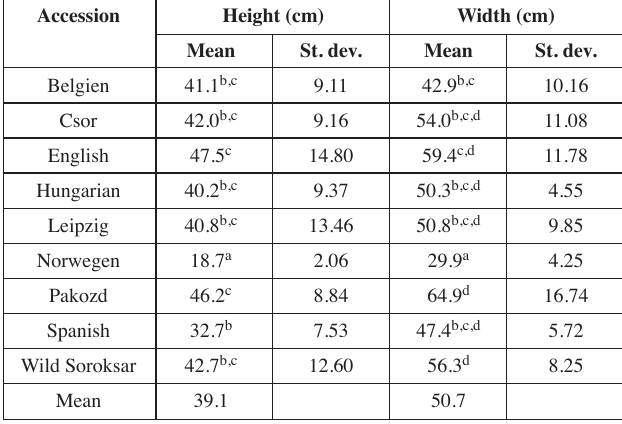
Tab. 4: Height and width of different wormwood